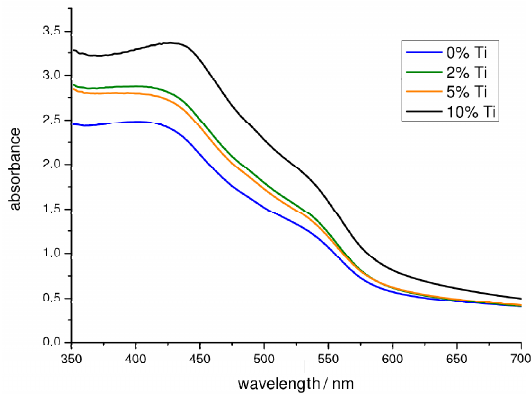
Figure 3. UV-Visible spectra of unmodified and Ti-modified hematite electrodes (2%, 5% and 10%).